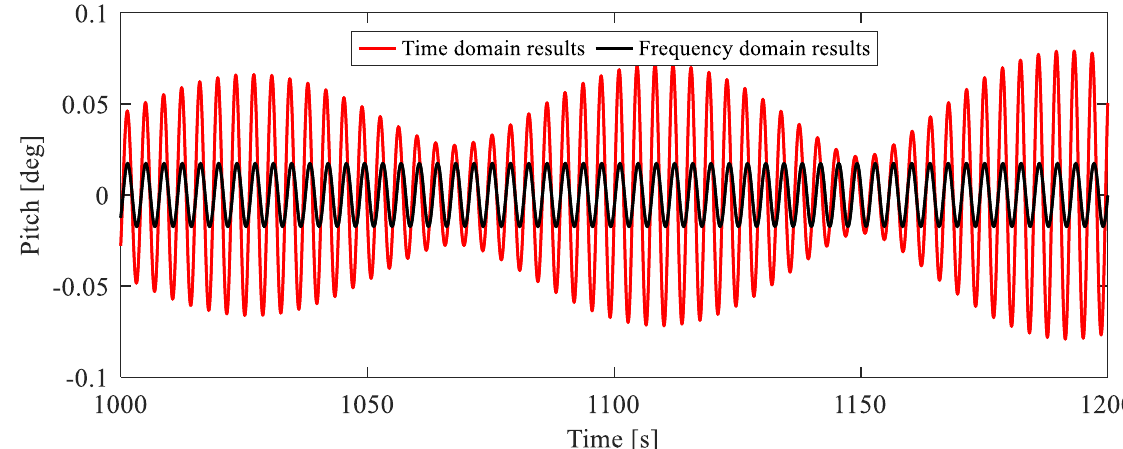
Figure 18. Comparison of windward module heave motions between frequency-domain results and time-domain results subjected to the regular wave ( H = 1 m, ω = 1.7 rad/s, α =